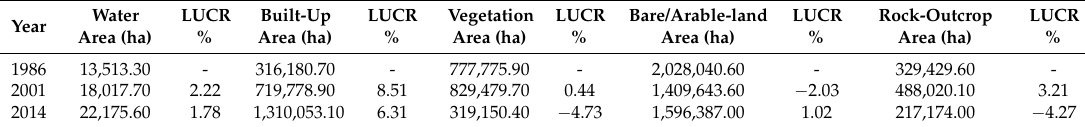
Figure 3. ( a ) Overlay of digitized open space and undevelopable area from the Abuja Master Plan (AMP) onto extracted 2014 built-up layer and AMP; ( b ) zoom-out of the overlay of digitized open space and undevelopable area from the AMP of Abuja for better visualization and ( c ) zoom of the AMP legend. Table 12. Annual Land Use Change Rate (ALUCR) and use change in Abuja from 1986 to 2014.